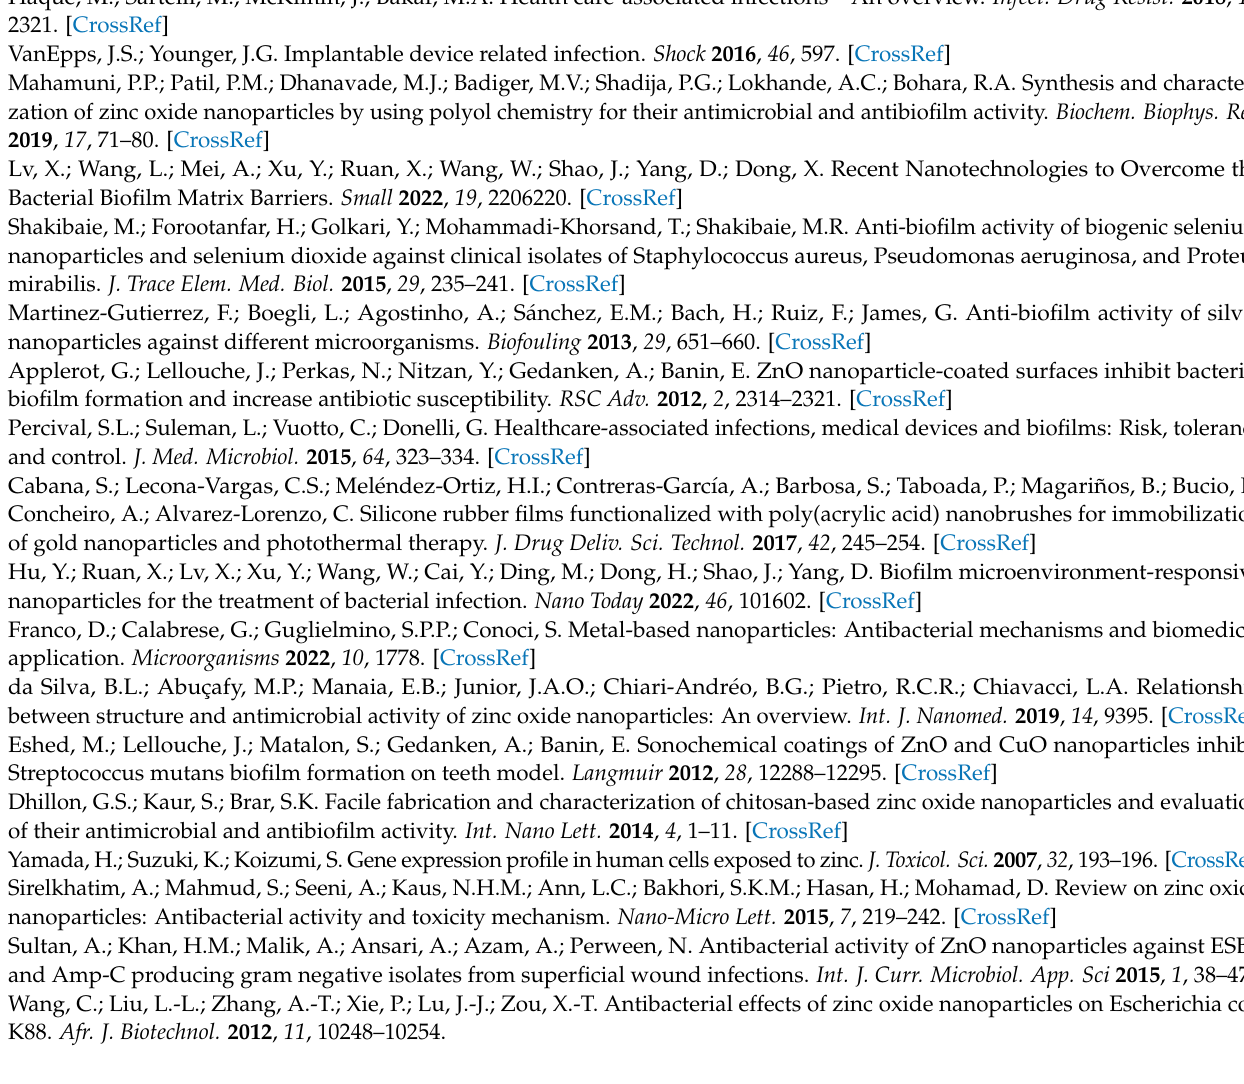
Figure S2: Transmission electron microscopy image of the synthesized ZnO NPs; Figure S3: Scanning electron microscopy (SEM) microphotograph of SR and